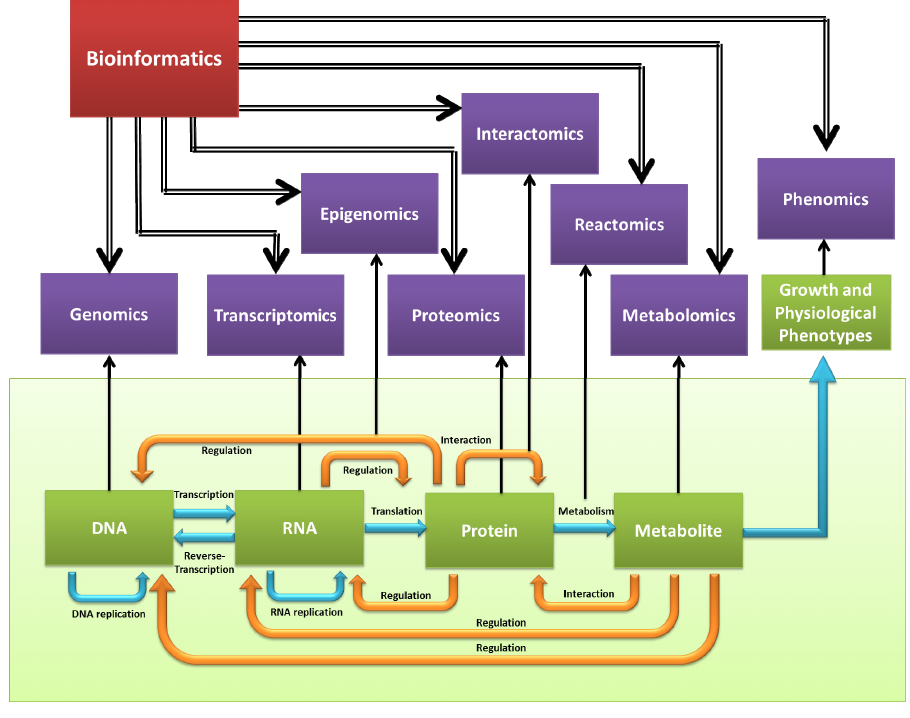
Figure 1. Infusion of biological “-omics” with